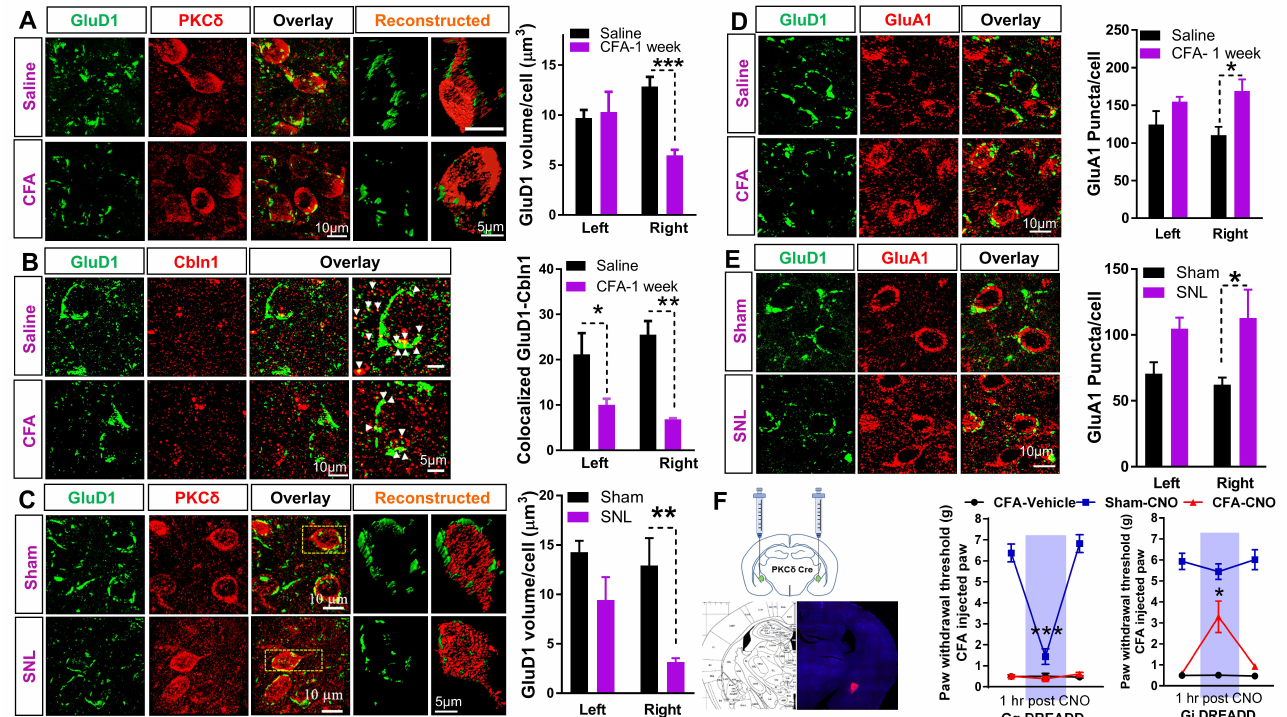
Figure 3. Inflammatory pain induces changes in GluD1, Cbln1, and GluA1 behavior. ( A ) GluD1 and PKC δ staining in CeLC was performed at 1 week after intraplantar CFA administration. Three-dimensional reconstruction and volume analysis of GluD1 elements in apposition with PKC δ + soma was performed. Significant reduction in somatic GluD1 volume specifically in the right CeA in CFA mice (Two-way ANOVA, treatment x side interaction F (1, 17) = 10.03, p = 0.0056, treatment F (1, 17) = 7.08, p = 0.016, Saline ( n = 4 mice left and 8 mice right) vs. CFA ( n = 4 mice left and 5 mice right): left CeA: 9.71 ± 0.81 vs. 10.30 ± 2.01; right CeA: 12.85 ± 0.97 vs. 5.97 ± 0.56, Bonferroni’s post hoc test, *** p = 0.0005). ( B ) GluD1 and Cbln1 co-labeling in CeLC performed 1 week after intraplantar CFA administration. A substantial reduction in GluD1-Cbln1 colocalized puncta number in right CeA is observed (Two-way ANOVA, treatment F (1, 12) = 26.65, p = 0.0002, Right CeA: Saline ( n = 4 mice): 25.5 ± 3.06 vs. CFA ( n = 4 mice): 6.83 ± 0.24, * p = 0.024, Bonferroni’s post hoc test). Reduction in GluD1-Cbln1 colocalized puncta is also observed on left CeA ( p = 0.037). ( C ) GluD1 and PKC δ co-labeling in CeLC performed 4 weeks after sham or SNL surgery in rats along with 3D reconstruction. Significant reduction is observed in perisomatic GluD1 volume in right CeA (Two-way ANOVA, treatment F (1, 12) = 14.66, p = 0.0024, Right CeA: Sham ( n = 4 rat): 12.92 ± 2.77 vs. SNL ( n = 4 rats): 3.17 ± 0.37, ** p = 0.007, Bonferroni’s post hoc test). No significant change in left CeA GluD1 volume ( p = 0.19). ( D ) GluD1 and AMPA receptor subunit GluA1 co-labeling in CeLC performed 1 week after intraplantar CFA administration. An upregulation of surface GluA1 is observed after CFA treatment (Two-way ANOVA, treatment F (1, 12) = 11.06, p = 0.0060, Saline ( n = 4 mice) vs. CFA ( n = 4 mice): Right CeA: 110.48 ± 11.00 vs. 168.98 ± 15.44, * p = 0.018 Bonferroni’s post hoc test. No significant difference in left CeA ( p = 0.26). ( E ) Upregulation of GluA1 subunit in CeLC of SNL mice (Two-way ANOVA treatment F (1, 12) = 11.37, p = 0.005, Sham ( n = 4 rats) vs. SNL ( n = 4 rats): Right CeA: 62.25 ± 5.32 vs. 112.89 ± 21.47, * p = 0.029, with Bonferroni’s multiple comparison’s post hoc test). ( F ) Chemogenetic modulation of PKC δ neurons using PKC δ -Cre mouse line. Representative image for site verification of DREADD injection. Activation of PKC δ + neurons in G q DREADD injected normal animals using CNO (Sham-CNO) led to an increase in mechanical sensitivity (One-way repeated measures ANOVA, treatment F (1.50, 7.53) = 64.01, p < 0.0001; Sham-CNO ( n = 6 mice); pre-CNO vs. 1 h post-CNO 6.373 ± 0.428 vs. 1.441 ± 0.365, *** p < 0.0001, Tukey’s post hoc test). No change was observed across different time points in the other two groups ( n = 4 mice for CFA-vehicle and 4 mice for CFA-CNO). In contrast, in CFA injected mice, inhibition of PKC δ + neurons in G i DREADD injected animals using CNO (CFA-CNO) significantly rescued mechanical hypersensitivity (One-way repeated measures ANOVA, treatment F (1.03, 4.13) = 12.88, p = 0.0215; CFA-CNO ( n = 5 mice); pre-CNO vs. 1 hr post-CNO: 0.591 ± 0.040 vs. 3.289 ± 0.748, * p = 0.0464, Tukey’s post hoc test). No difference was observed across different time points in the other groups ( n = 6 mice for CFA-vehicle and 4 mice for